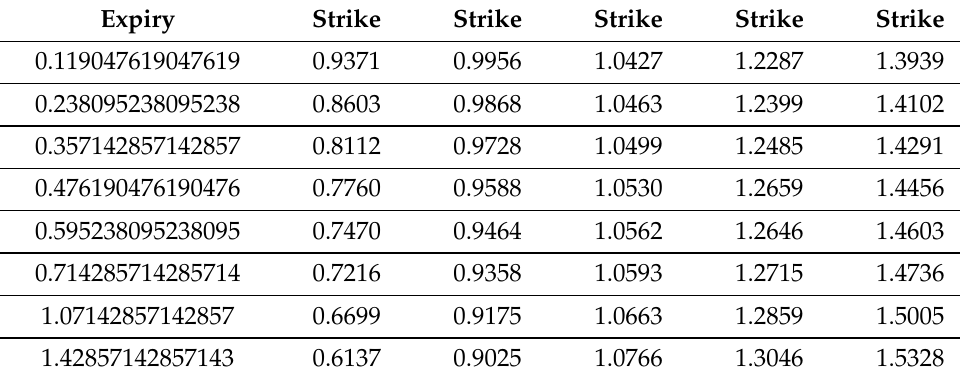
Table A2. Set 2 of strikes and